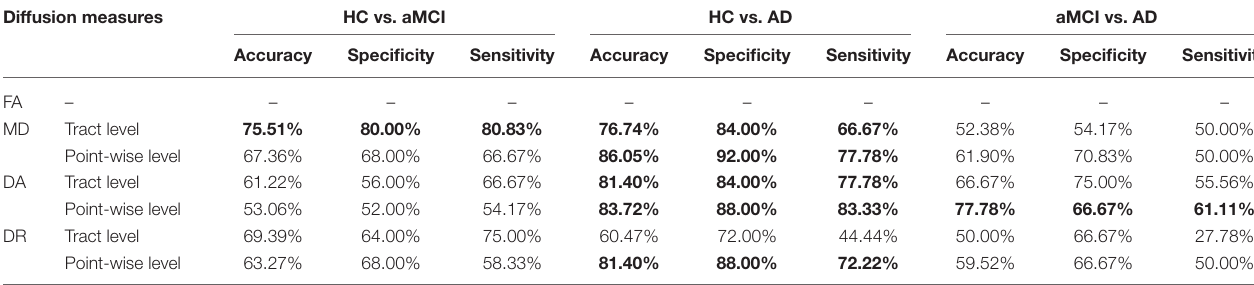
TABLE 4 | Discrimination results derived from the RF between HC, aMCI, and AD. Diffusion measures